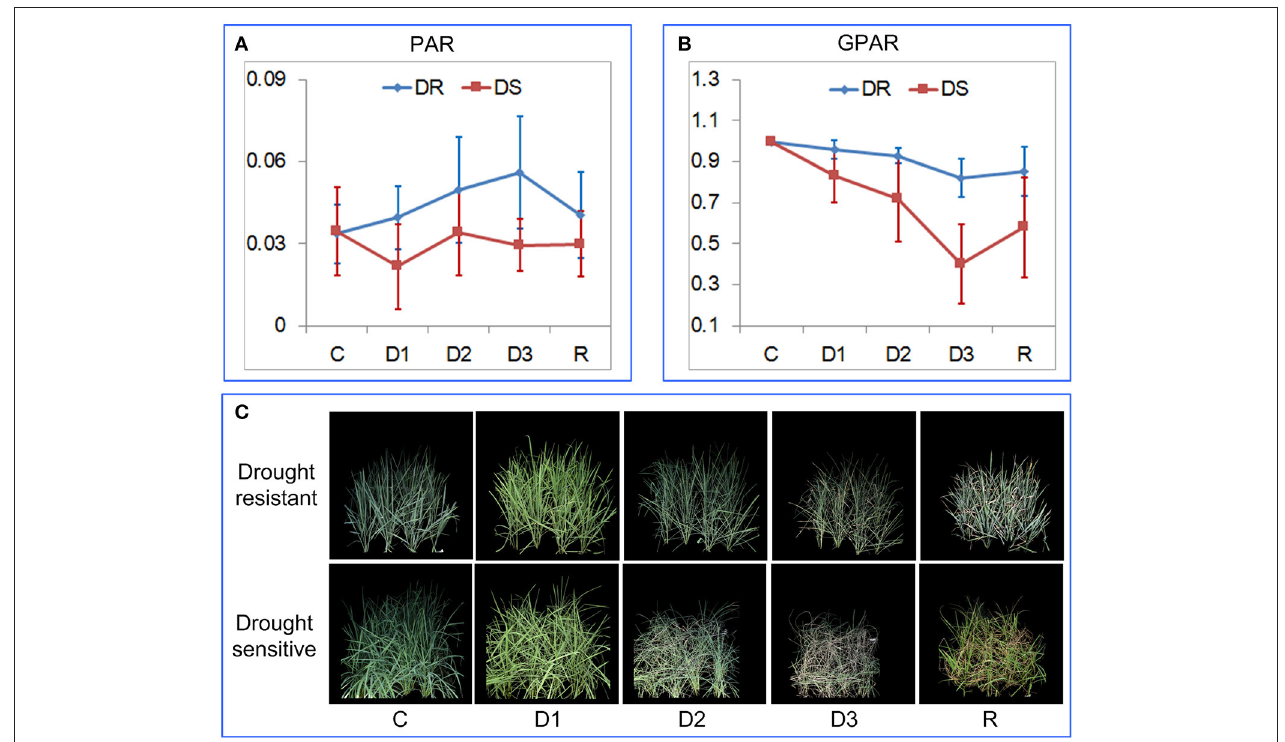
FIGURE 7 | Quantification of rice drought response under field conditions. (A) Dynamics of PAR at five time points. (B) Dynamics of GPAR at five time points. The markers and the bars in each line represent the mean value and standard deviation across the accessions, respectively. (C) A drought resistant accession and a drought sensitive accession at five time points. C, before stress; D1, mild drought stress; D2, moderate drought stress; D3, severe drought stress, and R: after